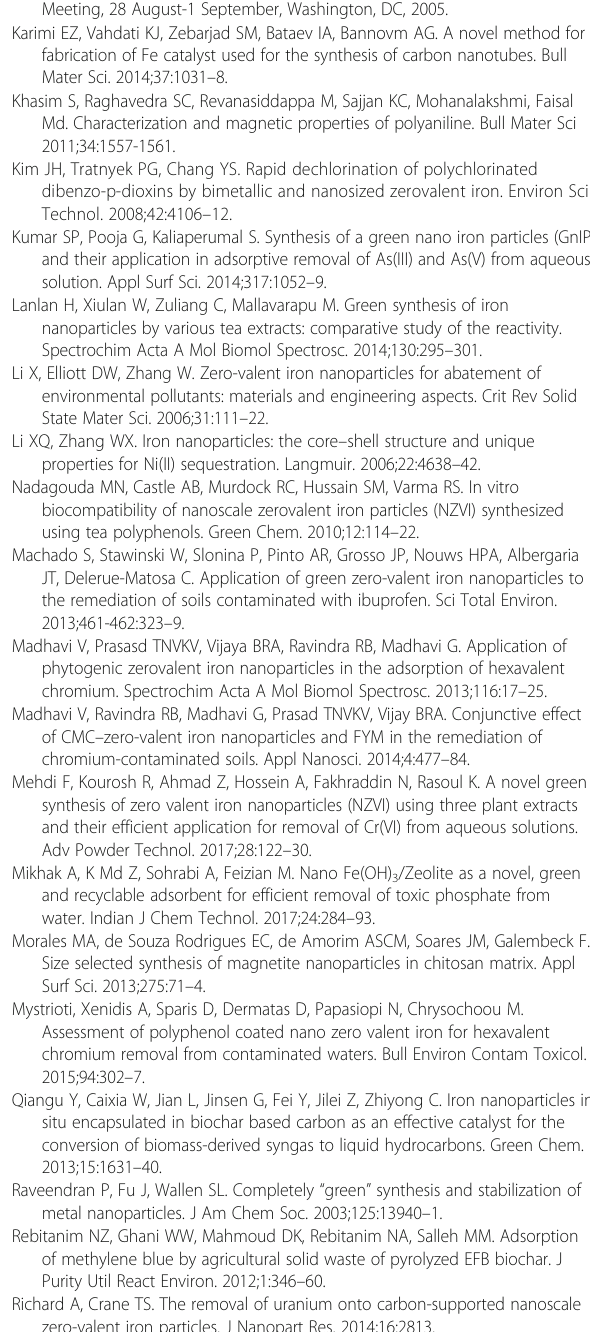
Table 3 Pseudo-second order parameters of adsorption